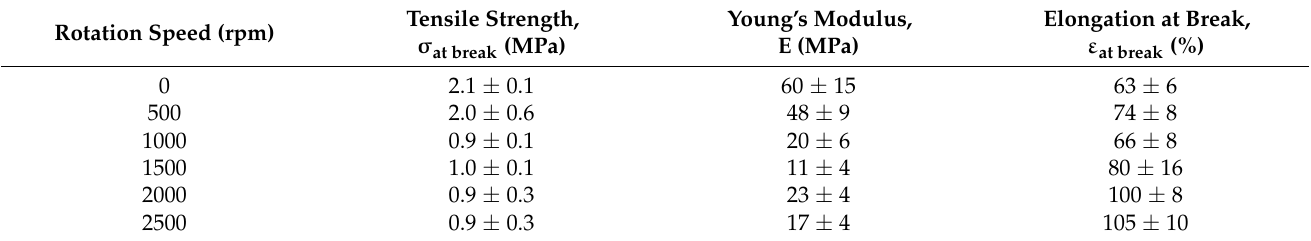
Table 3. Mechanical properties of PVC nanofiber mats with perpendicular orientation nanofibers. Rotation Speed (rpm)